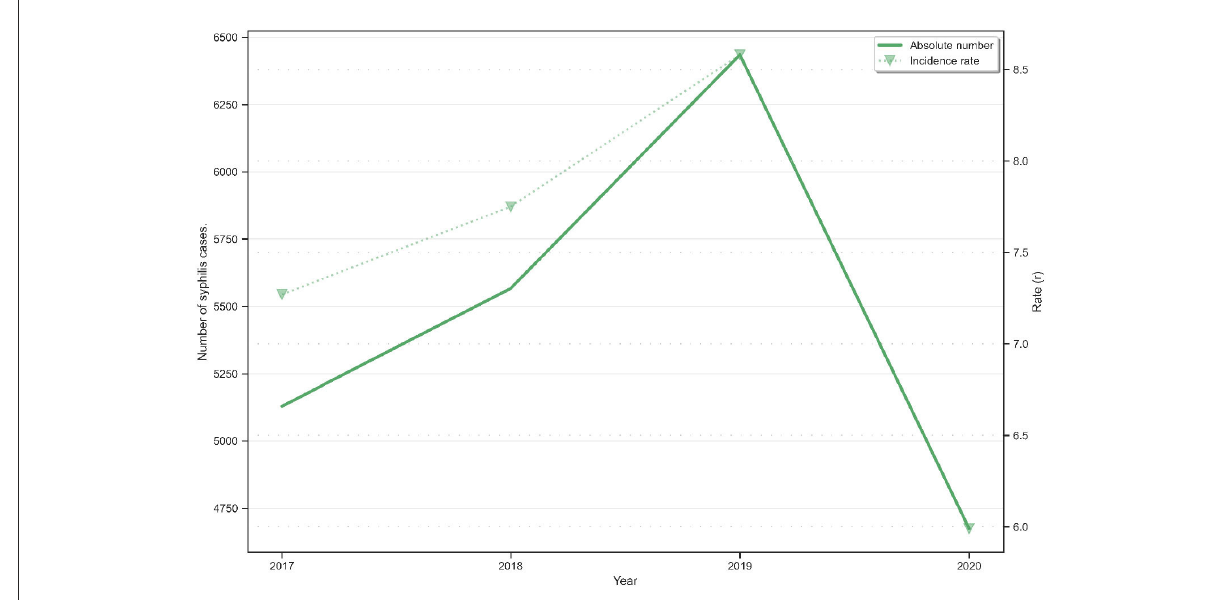
FIGURE6 Syphilis infections in the Brazilian Prison System and rate per 1,000 population (in relation to prison